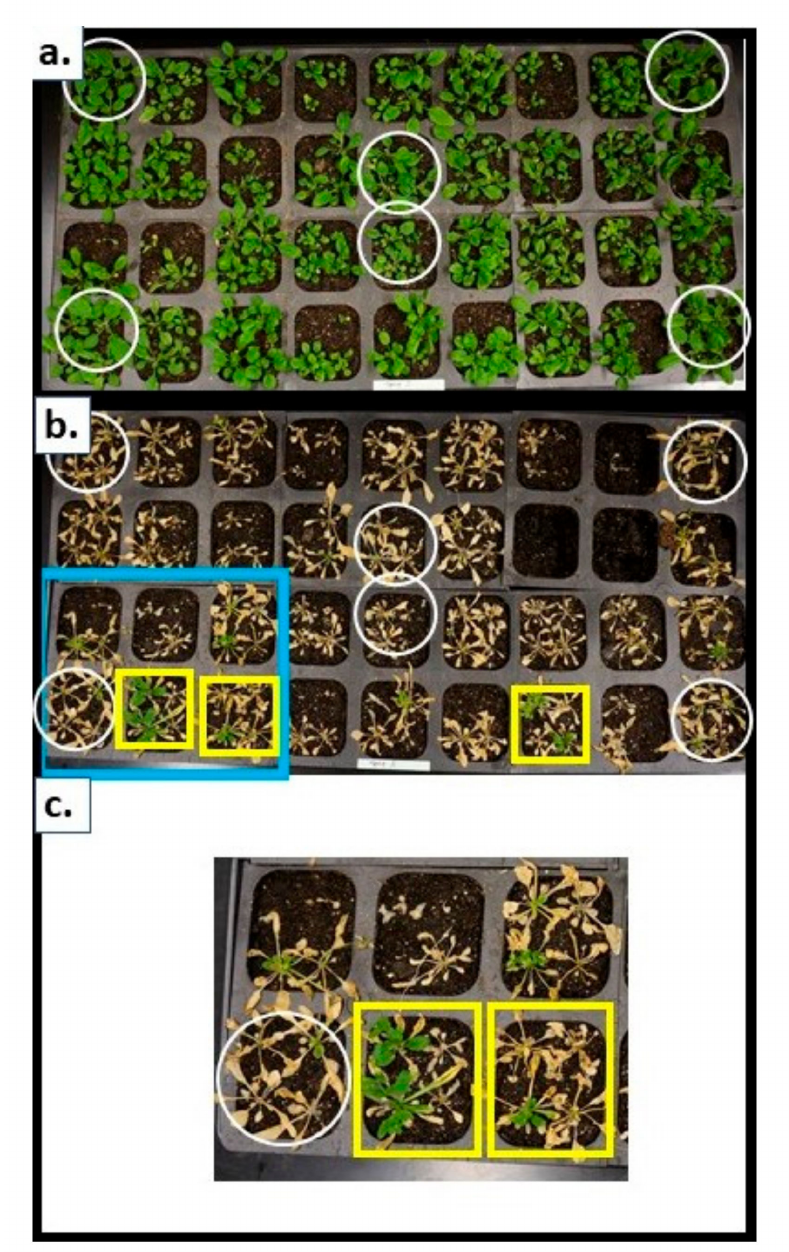
Figure 4. Screening apple FOX Arabidopsis lines for freezing tolerance. Three-week old seedlings were subjected to the following freezing program: − 1 ◦ C / h to − 6 ◦ C, 2 h soak at − 6 ◦ C, + 1 C / h to 0 ◦ C, soak for 4 h, + 2 ◦ C / h to 5 ◦ C, hold. The cell packs were then removed and returned to standard growth conditions. The plants were then scored as living / dead one week later. ( a ) Prior to freezing. ( b ) One-week after freezing. ( c ) Close up of cell pack outlined in blue in panel ( b ) with surviving apple FOX Arabidopsis seedlings. White circles: untransformed C0 controls. Yellow squares: individual cells / transgenic lines with potentially surviving apple FOX Arabidopsis